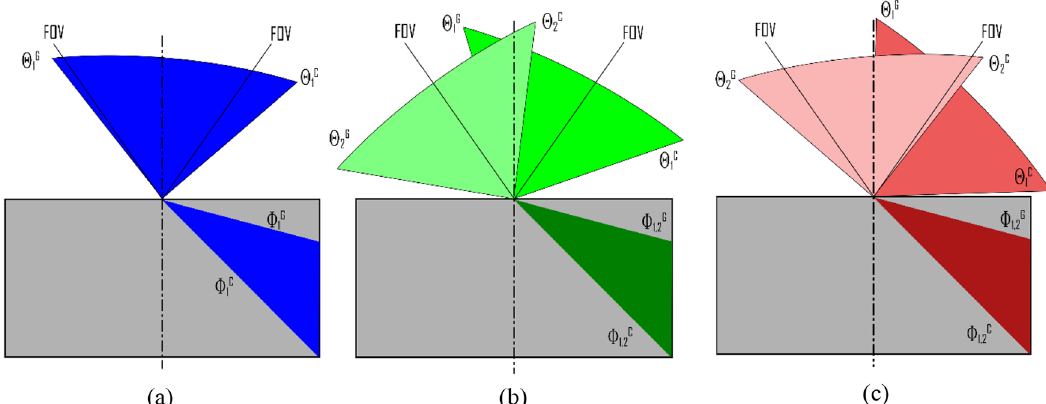
Fig. 11. Schematics of a single waveguide system with metasurface solution illustrating angles of incident and diffracted light for transmissive diffraction gratings for three different colors: (a) blue, (b) green, (c) red.